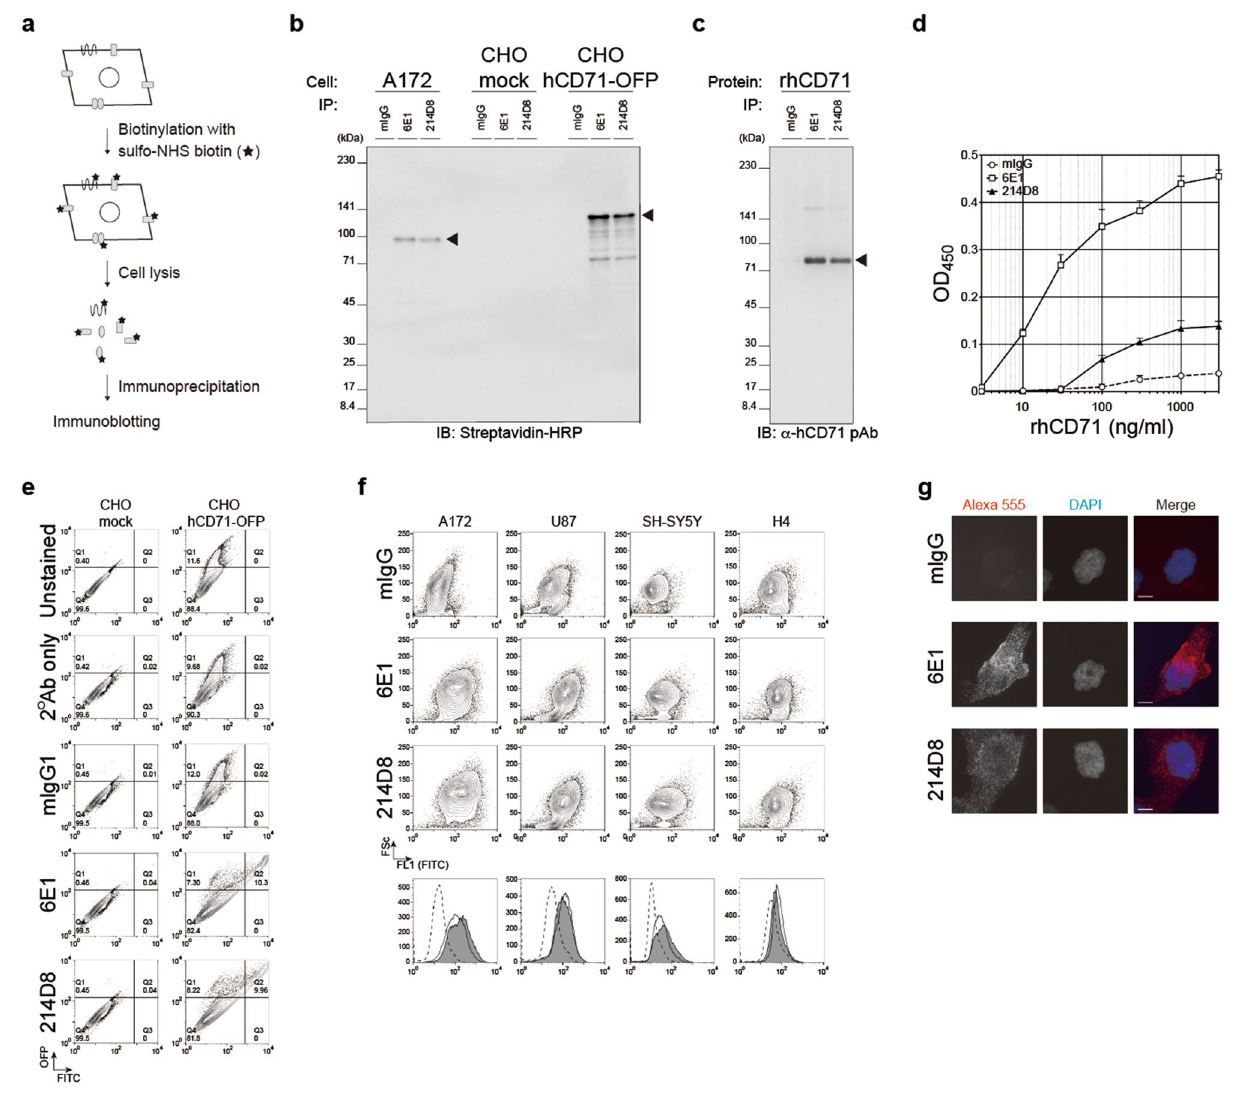
Figure 2. Characterization of functional antibody, 214D8. (a) Schematic diagram of profiling antigen. Cell surface proteins of A172, CHO mock or CHO hCD71-OFP cells were biotinylated with sulfo-NHS-biotin, and the cells were lysed to obtain biotinylated surface proteins. These proteins were subjected for immunoprecipitation and immunoblotting. (b) Full-length immunoblot of the biotinylated surface antigen. Following immunoprecipitation with the indicated antibodies, samples were electrophoresed, transferred, probed with streptavidin-HRP conjugate, and visualized by using chemiluminescent substrate. Putative antigen of 98-kDa band indicative of hCD71 and 125- kDa band indicative of hCD71-OFP were detected by immunoblotting. Representative results of two independent experiments. (c) Full-length immunoblot of purified rhCD71. Following immunoprecipitation with the indicated antibodies, samples were electrophoresed, transferred, probed with anti-hCD71 polyclonal antibody, and visualized by using chemiluminescent substrate. Putative antigen of 77-kDa band indicative of rhCD71 was detected by immunoblotting. Representative results of two independent experiments. (d) Detection of purified rhCD71 by sandwich ELISA. The purified rhCD71 was captured by anti-CD71 polyclonal antibody, detected by the indicated antibodies, probed with anti-mouse IgG HRP, and visualized by using TMB substrate. The mean absorbance values of quadruplicate samples at 450 nm are shown. Representative results of duplicate independent experiments. Data represent AVG ± SD. (e) Flow cytometry analysis of CHO cells overexpressing hCD71-OFP. The cells were stained with the indicated antibodies, and subsequently analyzed by flow cytometry. Data are visualized in scattered plots with FITC of secondary antibody and OFP of expressed hCD71-OFP protein. (f) Flow cytometric profiling of 214D8 antigen. Data are represented in the scattered plots of forward scatter (Fsc) and FITC (FL1) as secondary antibody of anti-CD71 antibodies including 6E1 and 214D8 as well as control mouse IgG. In histograms, data indicated FITC fluorescent intensity of control (dotted white), 6E1 (white) or 214D8 (gray) respectively. Representative data of two independent experiments. (g) Immunocytochemical analysis of A172 cells. The cells were stained with the indicated antibodies, followed by Alexa555 donkey anti-mouse IgG (H + L) secondary antibody, and counterstained with DAPI. 6E1 and 214D8 antibodies, but not mIgG, demonstrated membranous and cytoplasmic staining patterns. Representative results of two independent experiments. Scale bar = 10 µm. Magnification =